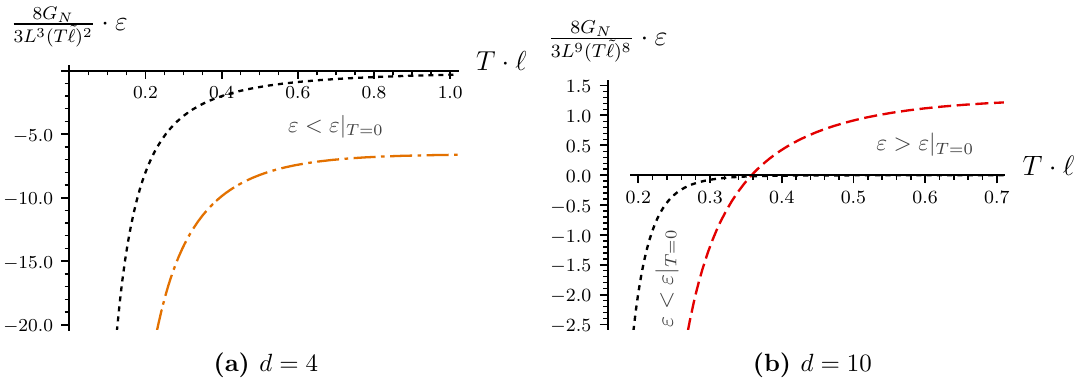
Figure 13. Entanglement negativity for di(cid:11)erent dimensions. We subtracted the cut-o(cid:11) term. The dotted black line is the zero-temperature